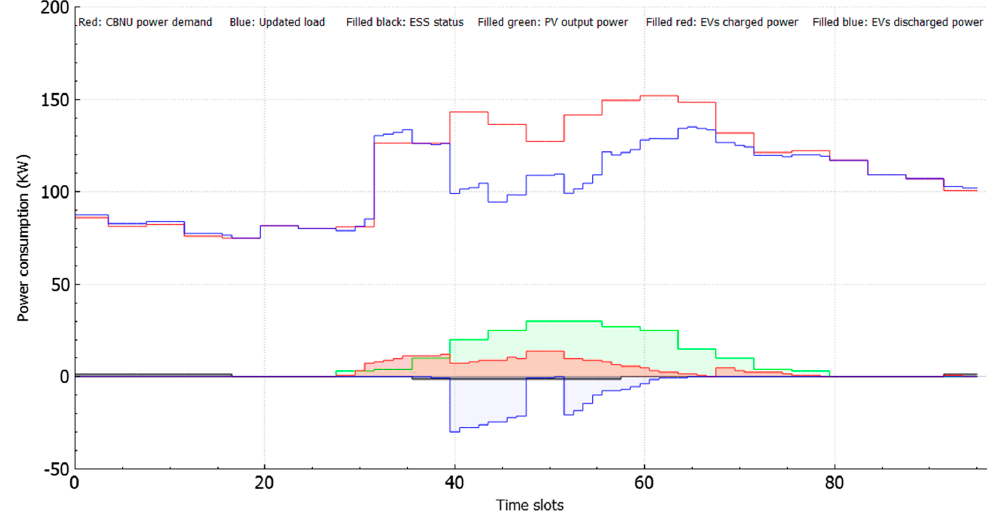
Figure 9. Results of scenario four with 100 EVs, a PV system of 30 kWh and an ESS of 50 kWh.